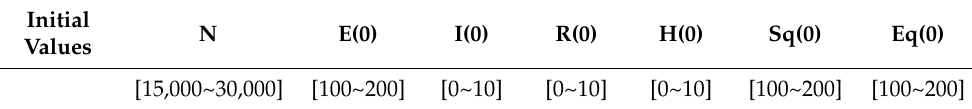
Table 11. Initial values of the starting time of the disaster areas. Initial